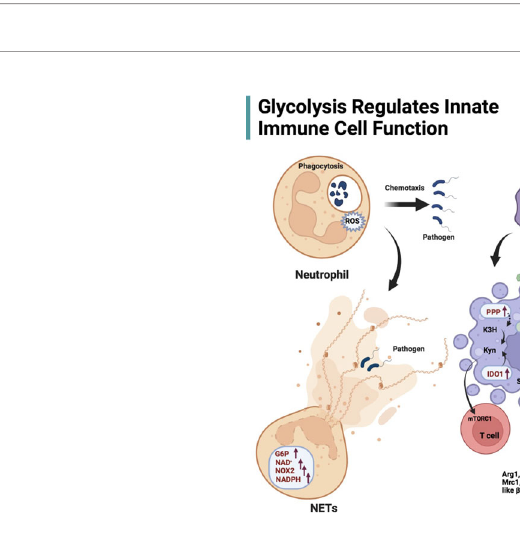
FIGURE 1 | Simpli fi ed fl owchart of glycolysis. Glucose entering cells is metabolized by HK to G6P, which provides a substrate for PPP. PPP generates ribose 5- phosphate and abundant NADPH. Those NADPH-dependent hydroxylases are manipulated by PPP activity, such as K3H. G6P undergoes a series of oxidative decompositions to generate 3-phosphoglycerate, providing raw materials for serine/glycine biosynthesis. PKM2 controls the fi nal step of glycolysis and generates pyruvate. The produced pyruvate is used mainly in OXPHOS and the tricarboxylic acid TCA cycle to generate more ATP. Monocarboxylate transporter 4, MCT4; Lactic dehydrogenase A, LDHA; Phosphofructokinase-1, PFK-1; Fructose-2,6-bisphosphate, F2,6BP; Kynurenine 3-hydroxylase, K3H.